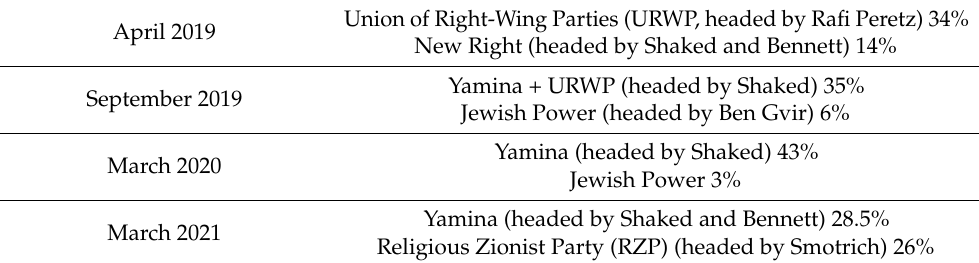
Table 1. RZS voting for RZS parties, 2019–2021